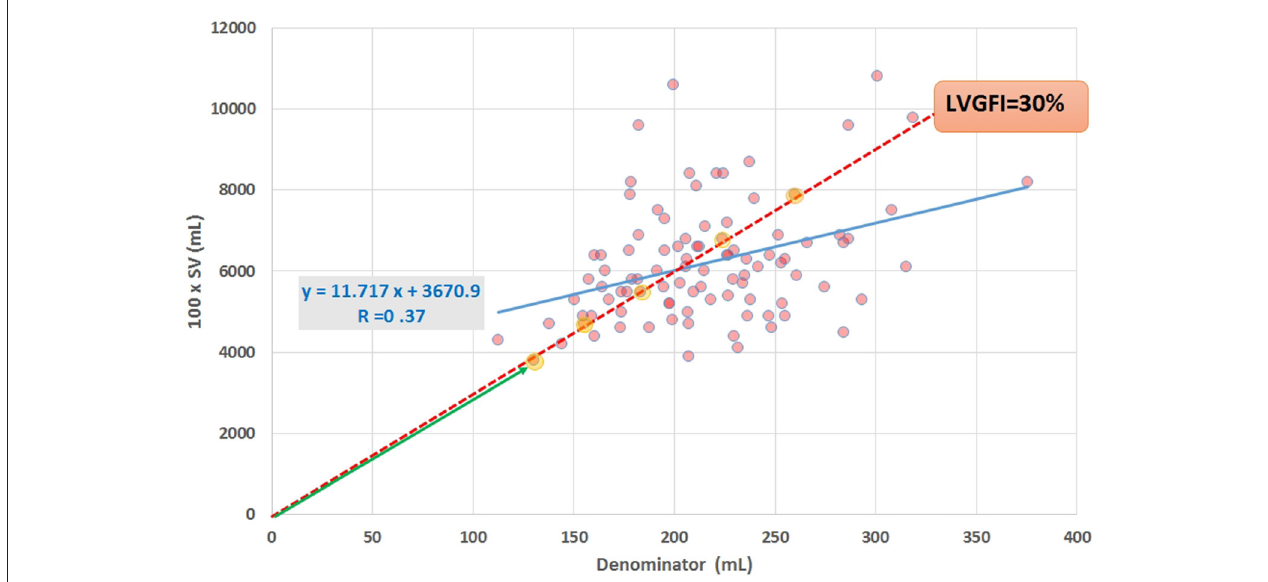
FIGURE 1 | Scatter plot of data obtained by CMRI in 96 cardiac patients, showing SV (multiplied by 100 for scaling purposes) vs. the denominator in equation (1). Regression line (blue) and equation are included. The slope of the red broken line corresponds with the ratio formulated in equation ( 1), for the case that the ratio LVGFI is 30%. All (yellow marked) points on or very close to this line share the same value of the ratio, illustrating that the ratio itself is not unique. Further characterization of individual points requires specification of the corresponding hypotenuse (such as the length of the green line with arrow head for the lower-left